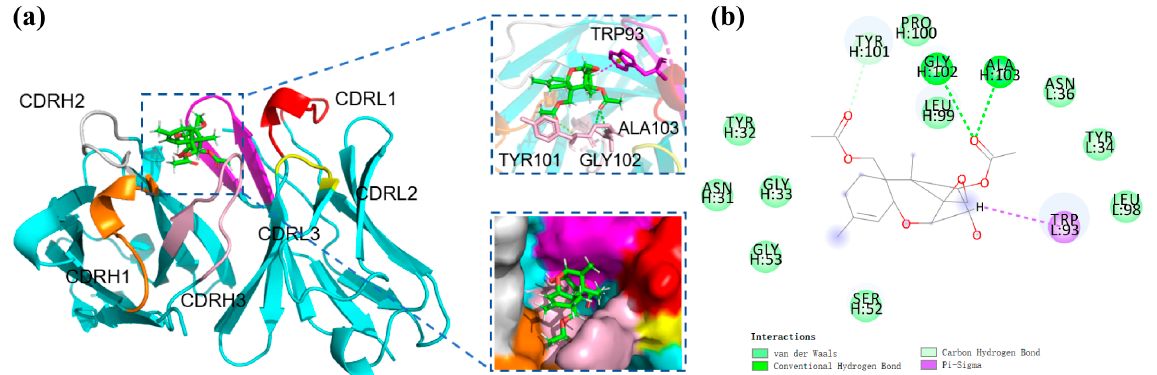
Figure 4. Molecular docking of the scFv − DAS interaction. ( a ) Molecular docking of scFv 8A9 and DAS, ( b ) 2D views of DAS interacting with the scFv. The red, yellow, and purple components are CDRL1, L2, and L3, respectively; and the orange, silver, and pink components are CDRH1, H2, and H3, respectively. Hydrophobic interactions are shown as purple dashes and hydrogen bonds are displayed as green dashed lines.